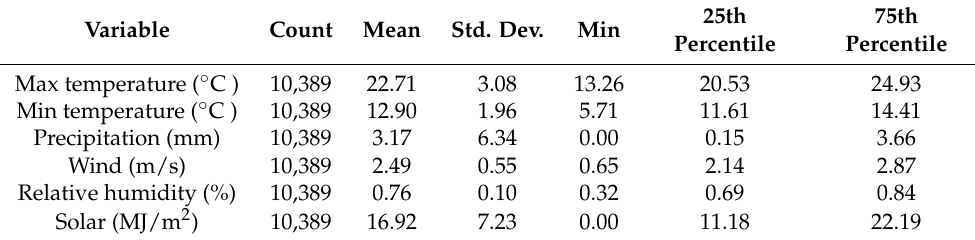
Table 1. Descriptive statistics of weather variables used in